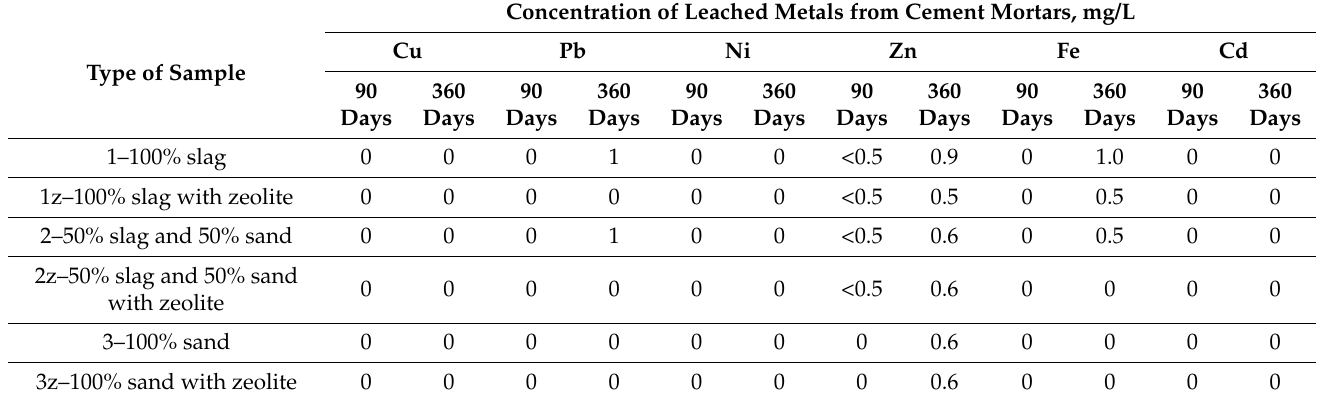
Table 5. Concentration of leached metals after 90 and 360 days.